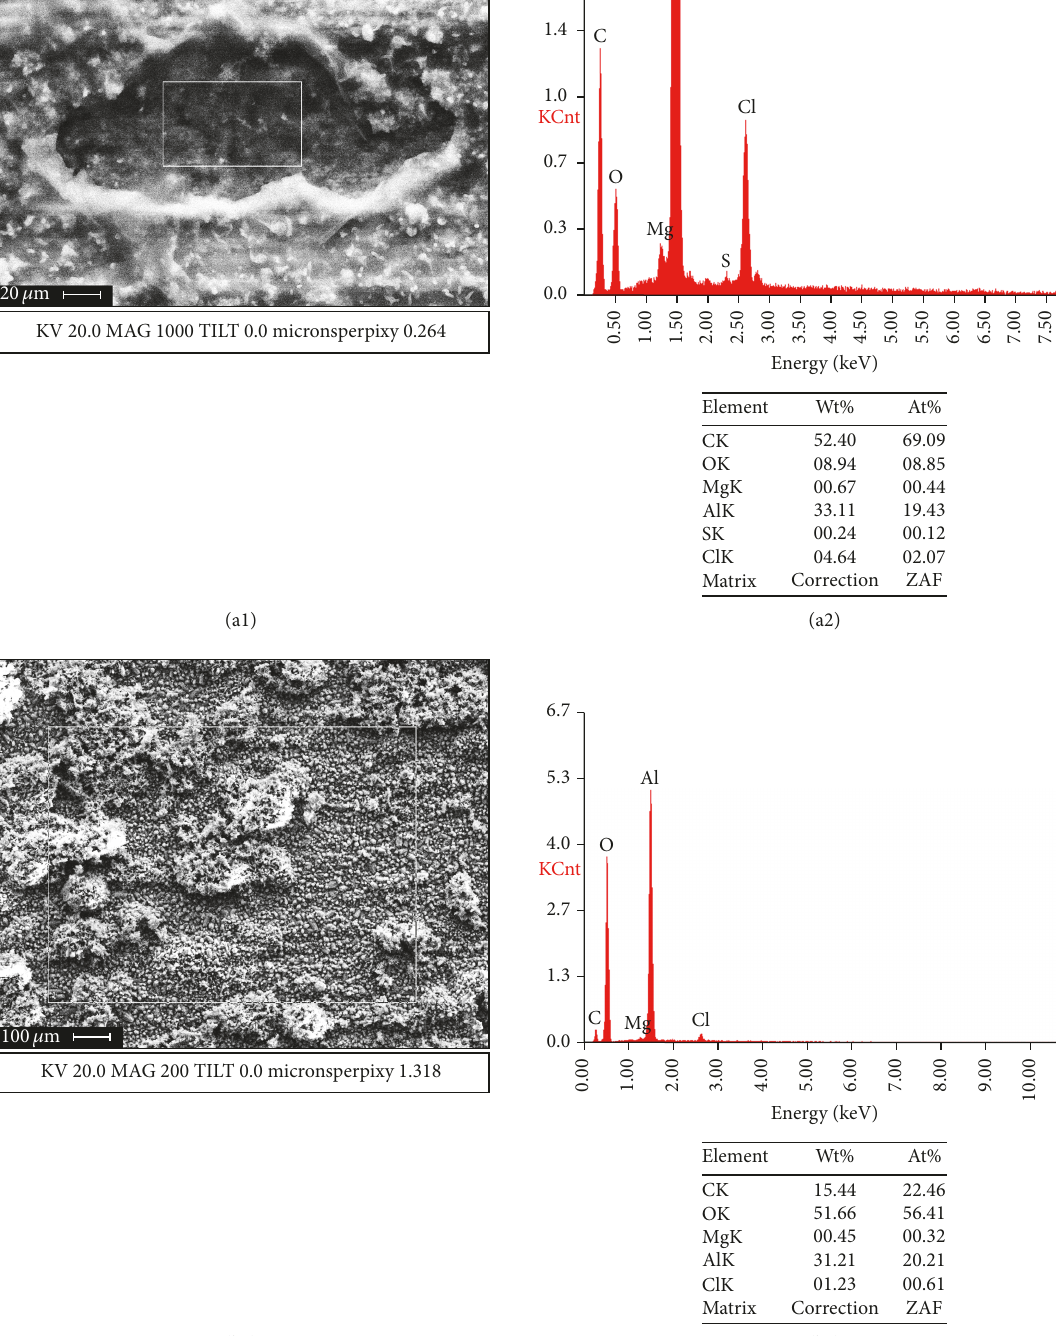
CHI660D electrochemical workstations are used to mea- sure three electrode systems which are made of a plat- inum sheet auxiliary electrode with area of 1 cm 2 , a satu- rated calomel reference electrode (SCE), and the